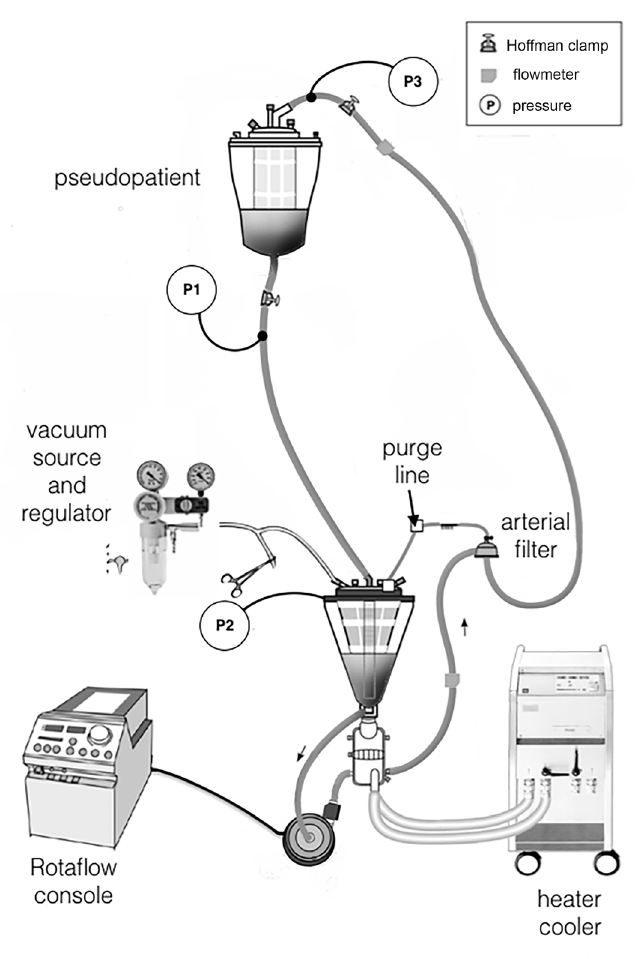
Fig. 1 – The circuit employed in this study simulating a pediatric cardiopulmonary bypass with a centrifugal pump as the main pump. Two Hoffman clamps were used to control the venous drainage and the post-cannula pressure (adjusted to 50 mmHg at the beginning of each range of flow – 1500, 2000, and 2500mL). Two flow probes were placed into the arterial line before and after the arterial filter. Pressure was measured in three sites: at the venous limb close to the pseudopatient (P1), at the cardiotomy venous reservoir (P2), and post-arterial cannula site